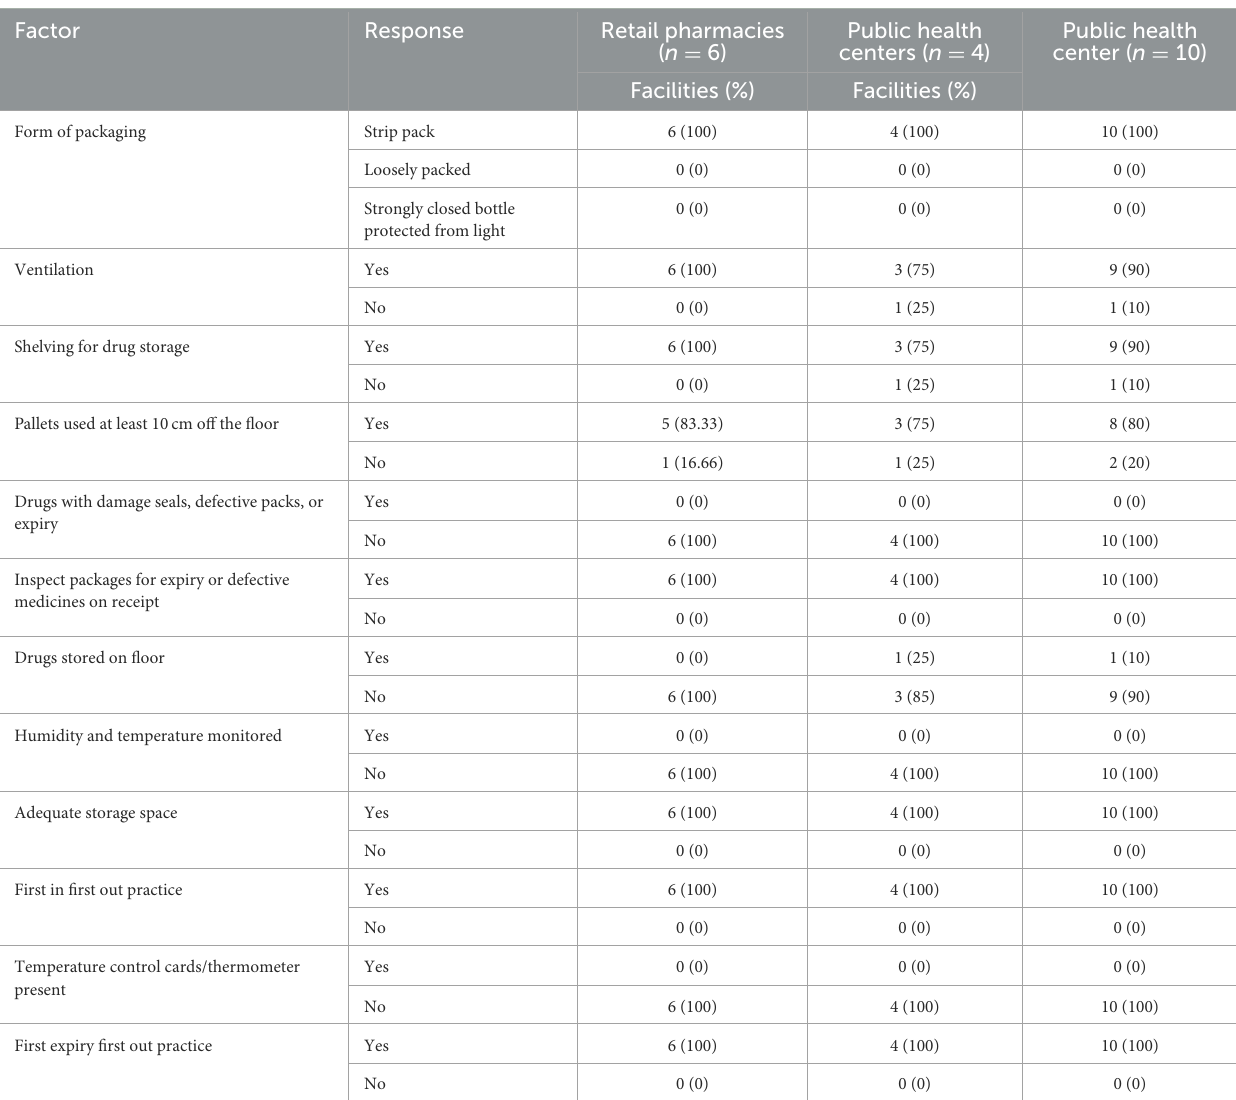
TABLE 5 Storage conditions of FDC among selected